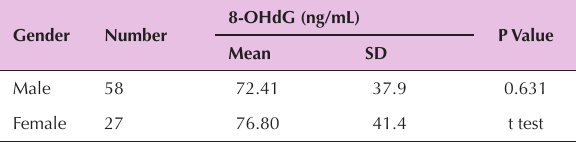
Table 4. Mean and standard deviation of 8-OHdG serum level and comparison between males and females Gender